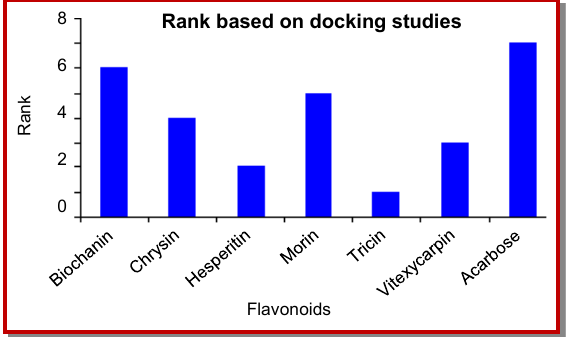
Figure 4: α-amylase inhibitory activity of flavonoids based on docking